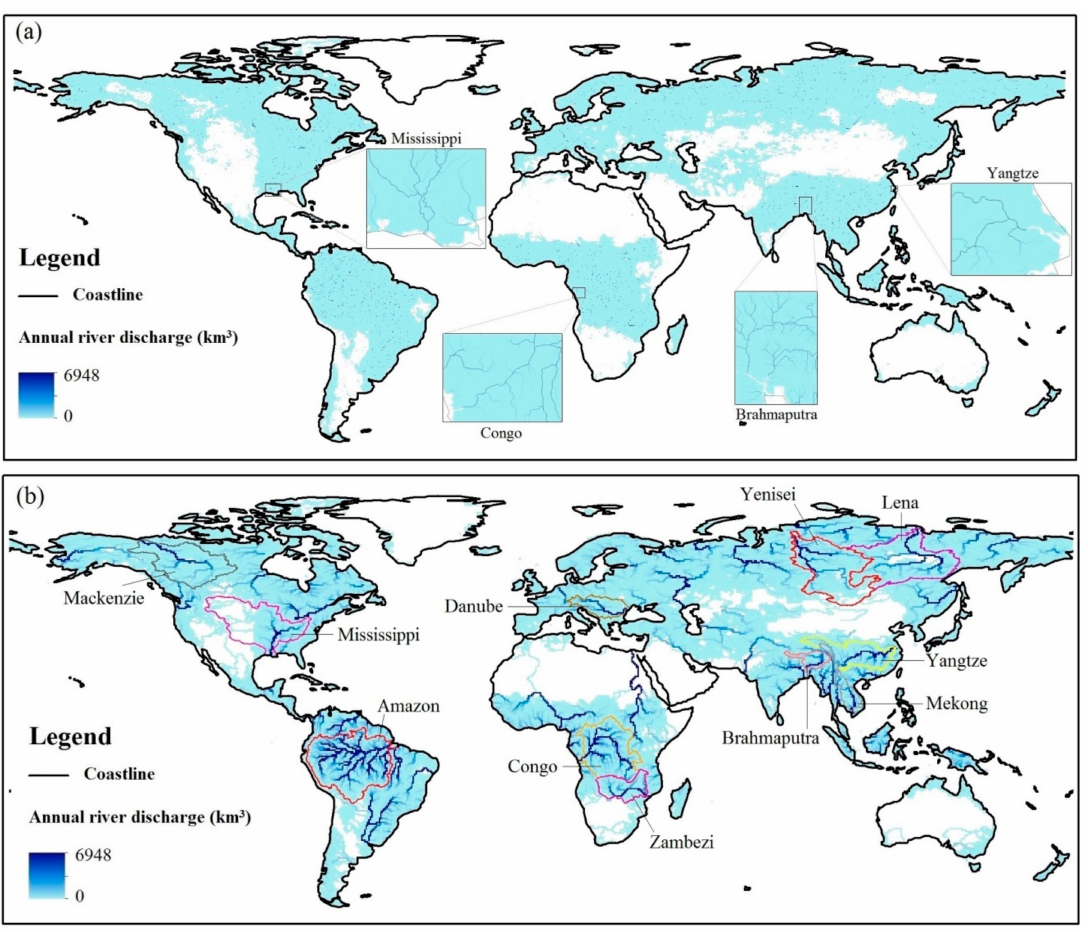
Figure 3. The global maps of the mean annual river discharge with spatial resolutions of ( a ) 0.01 degrees and ( b ) 0.5 degrees, respectively.